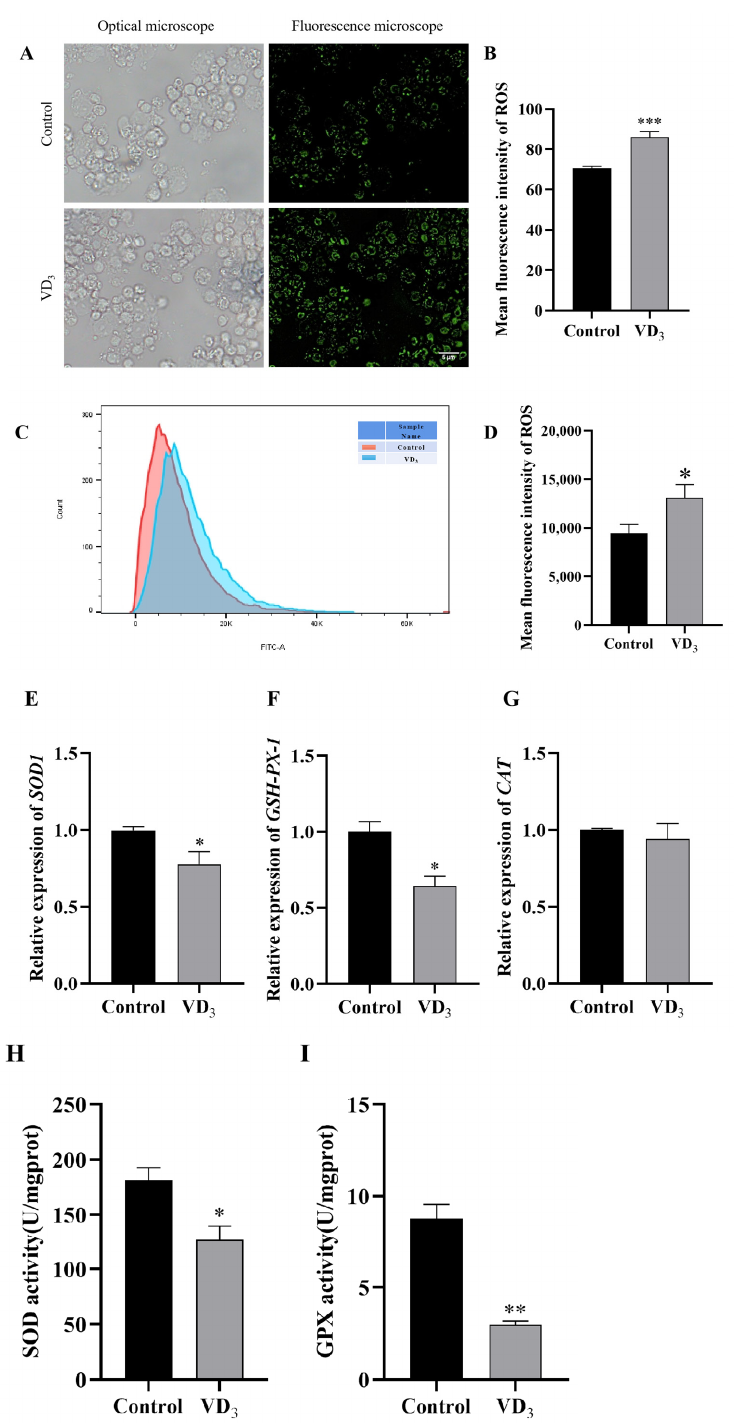
Figure 2. 1 α ,25(OH) 2 D 3 increases intracellular ROS in PGCs. ( A ) The intracellular ROS was measured by fluorescence microscope (green fluorescence intensity represents ROS levels), and the ROS content in PGCs was evaluated ( B ). ( C ) The intracellular ROS was measured by flow cytometry, and the ROS content in PGCs was evaluated ( D ). Relative gene expression of SOD1 ( E ), GSH ‐ PX ‐ 1 ( F ), and CAT ( G ) were measured in PGCs. Enzyme activities of SOD ( H ) and GPX ( I ). Bar = 5 μ m. VD 3 : 1 α ,25(OH) 2 D 3 . Data are means ± SE of three independent replicates (* p < 0.05, ** p < 0.01, *** p < 0.001).